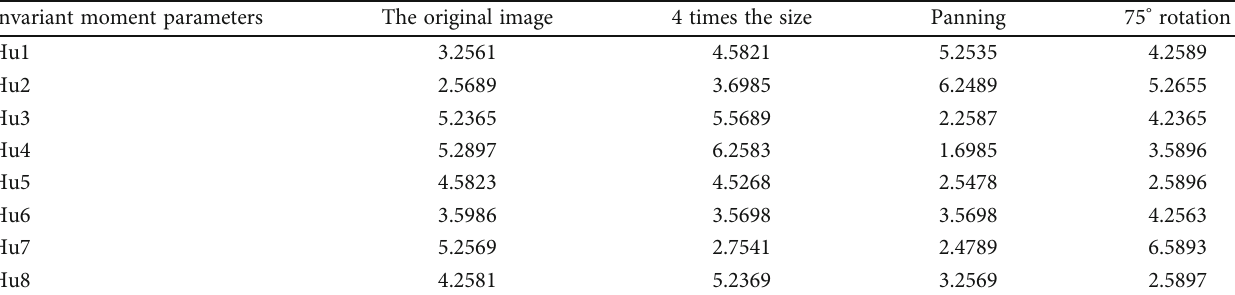
Figure 11: QRT-PCR results of upregulated and downregulated genes. Table 3: Hu moments of ski trajectory images under three geometric